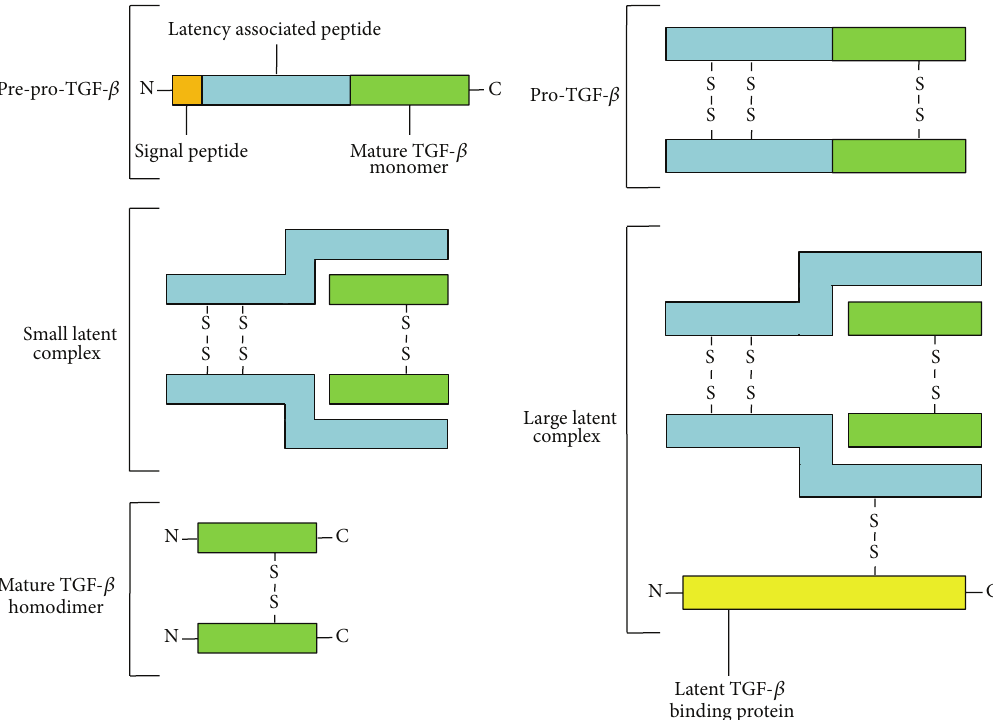
Figure 2: A schematic representation of TGF- 𝛽 different forms occurring during synthesis, secretion, and activation.